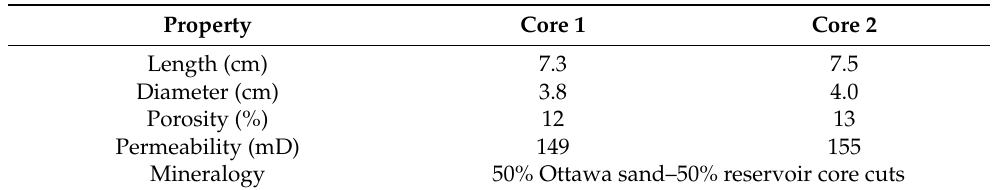
Table 1. Properties of the porous media used for the optimal scenario of bio-fluid (Core 1) and bio-nanofluid injection (Core 2).